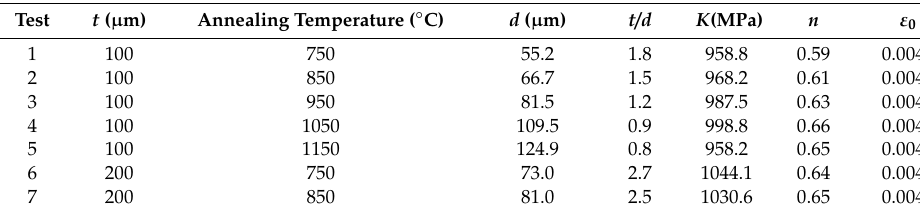
Figure 5. Microstructures of Ni sheets with annealing temperature of 100 μ m: ( a ) 750 °C, ( b ) 850 °C,